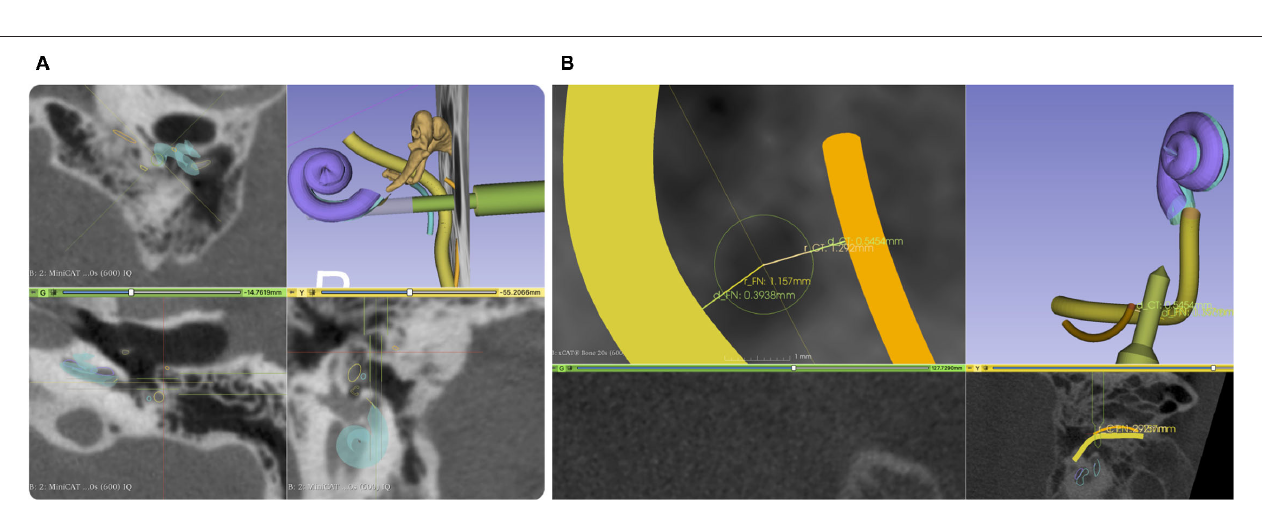
FIGURE 4 | (A) Mounting X-ray marker (blue). The X-ray marker has dense markers embedded, which help to localize the markers in the imaging and thereby the position of the frame can be determined. (B) Acquiring a cone beam computed tomography (CBCT) scan. To avoid contamination, the patient’s head is covered with sterile foil.